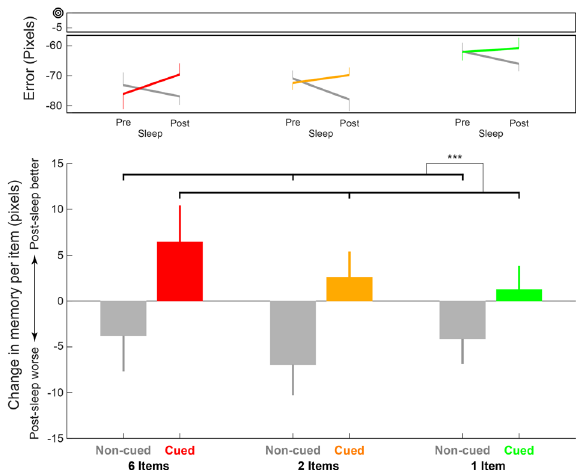
Fig. 2 Cuing status, but not set size, affected sleep-related bene fi ts. The upper panel shows mean error rates before and after sleep as a function of set size (red – six-item sets; yellow – two-item sets; and green – one-item sets) and cuing status (colored – cued; gray – non-cued). Zero error signi fi es exact recall of the correct location. The lower panel shows the change in memory over sleep (i.e., sleep-related bene fi t). Negative values represent higher errors after sleep. There was a signi fi cant effect of cuing status but no signi fi cant effect of set size and no cuing by set size interaction. Error bars signify standard error of the mean (between- subjects). *** p <